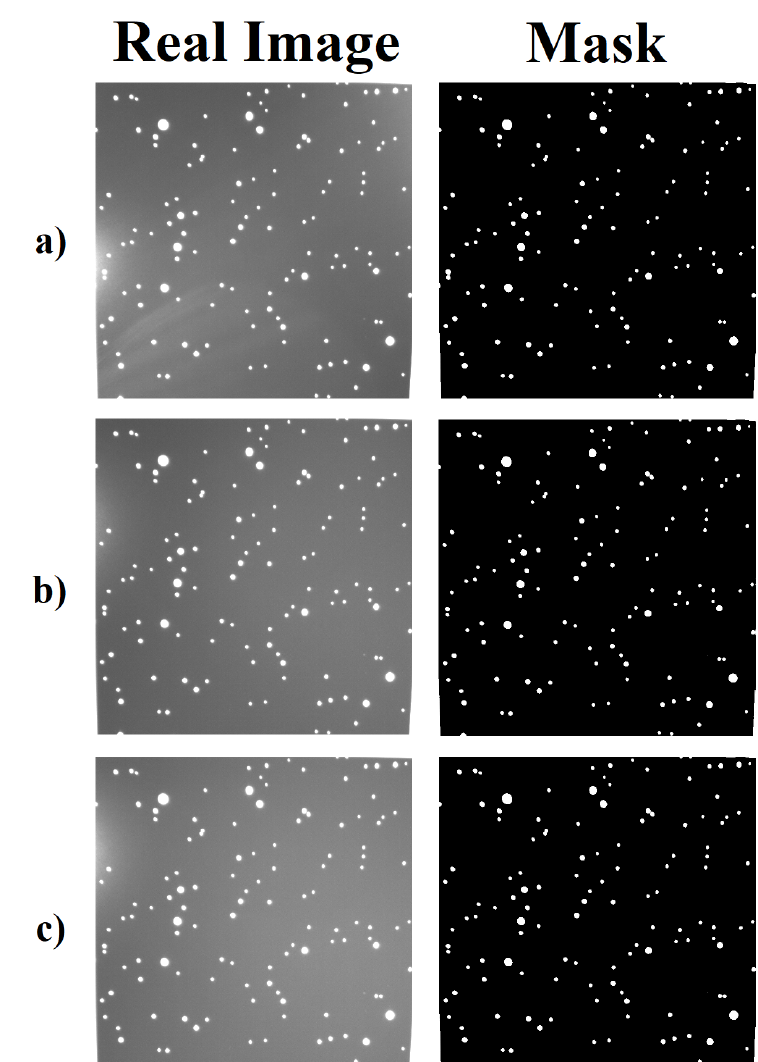
Figure 9. Left column: images from NSSF with ghost noise; right column: segmented images by the BOSS algorithm; from top to bottom three different ghost noise scenarios ( a – c